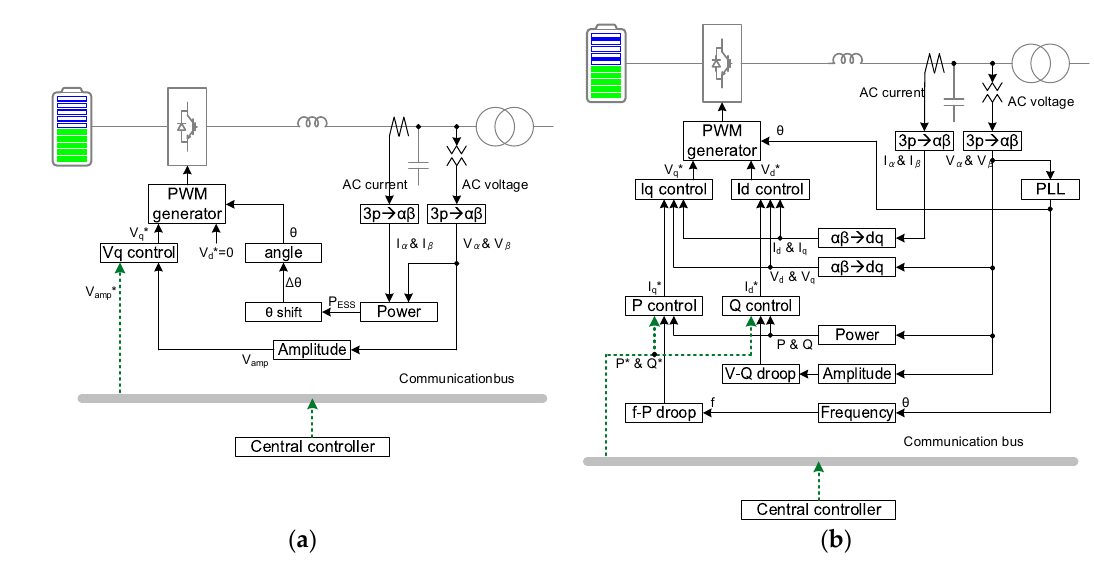
Figure 3. Control sequence of the proposed control method.